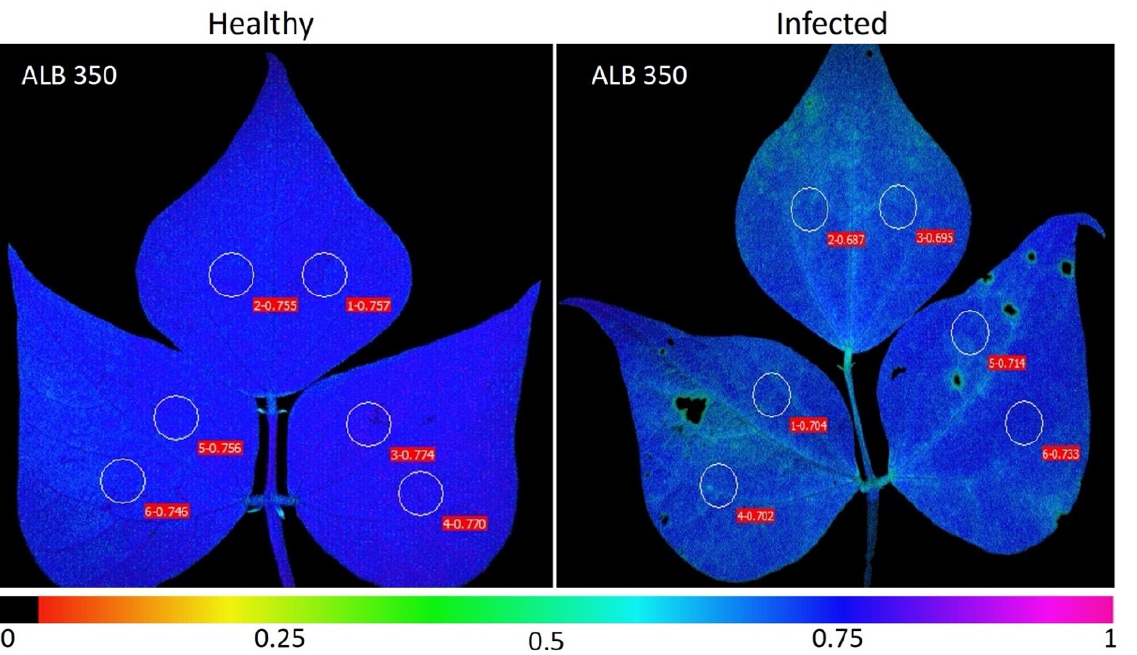
Figure 10. Selected areas of interest (AOIs) in each leaflet of healthy and infected leaves of Phaseolus vulgaris . The figure shows the maximum quantum efficiency of PSII (F v /F m ) for healthy and infected leaves. The color gradient showing a blue color in healthy leaves indicates leaves without disease stress. The green color indicates a decrease in the value of the F v /F m ratio as a response to disease stress.